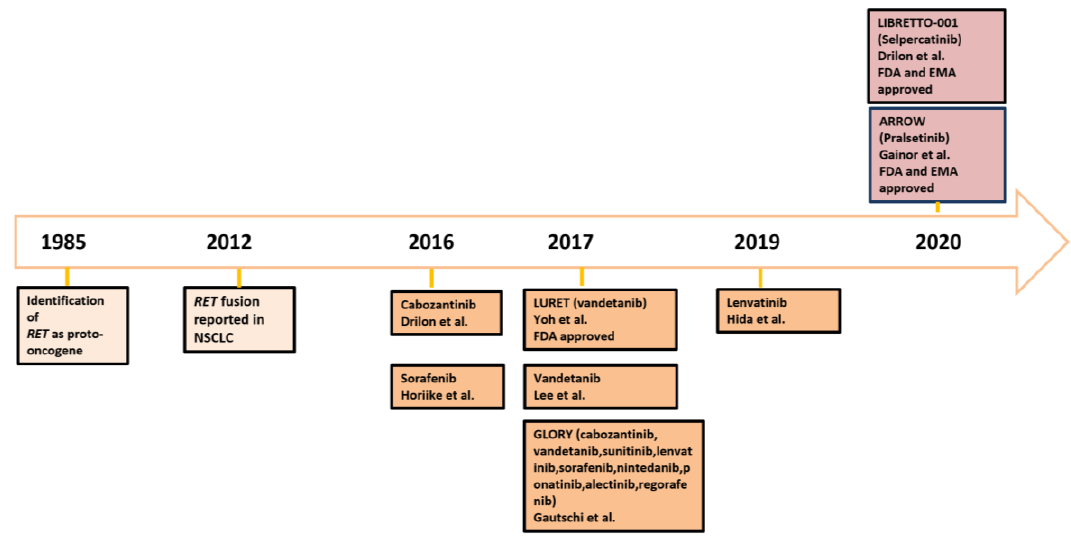
Figure 1. Timeline of advances in RET fusion NSCLC.